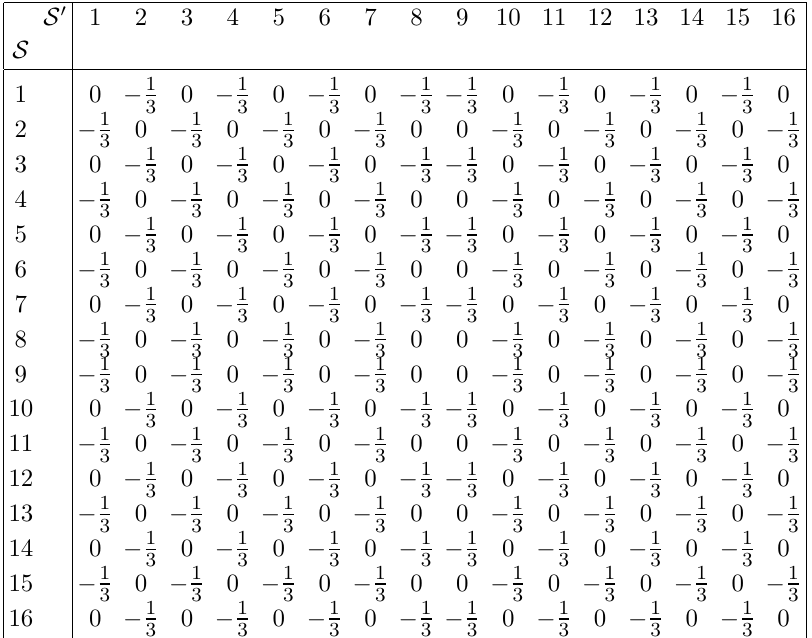
Table 30 . Gadget values for P